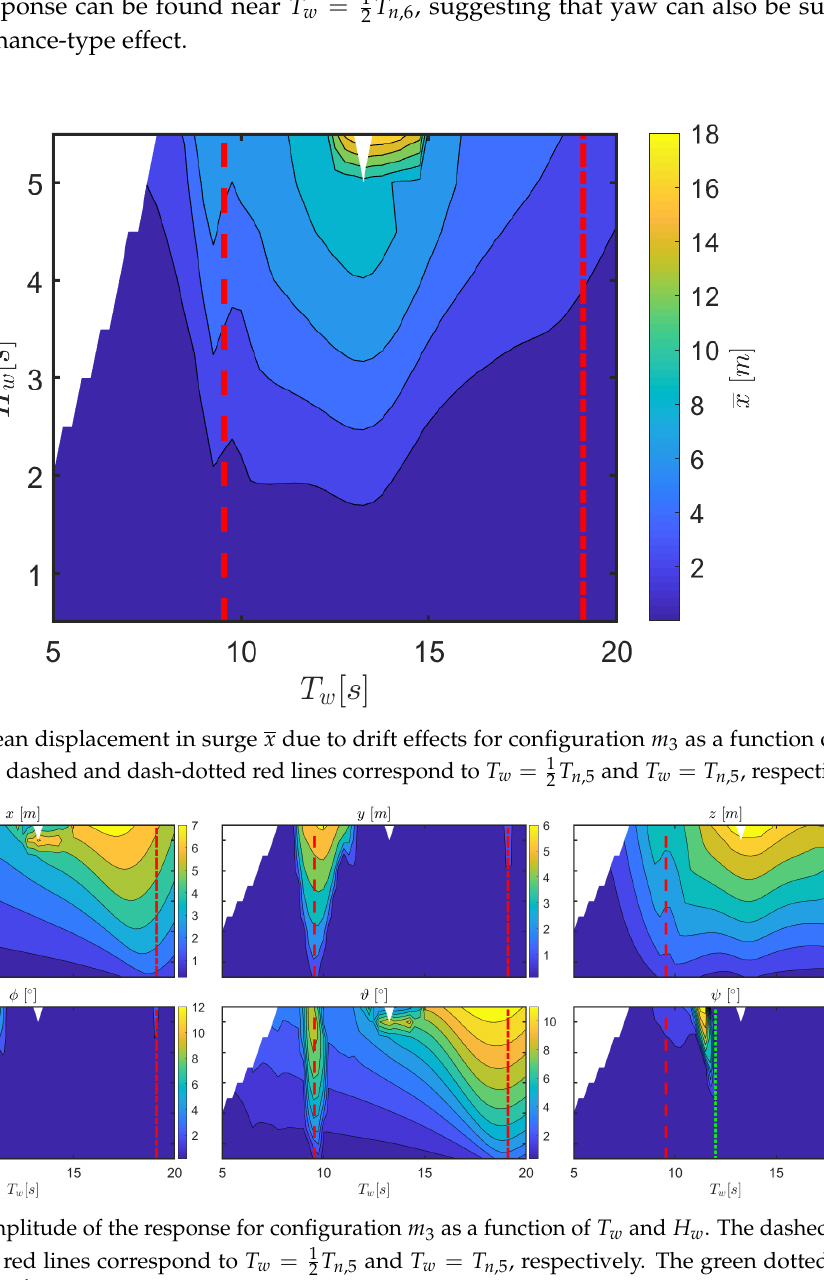
Figure 6. Amplitude of the response for configuration m 3 as a function of T w and H w . The dashed and dash-dotted red lines correspond to T w = 1 T n ,5 and T w = T n ,5 , respectively. The green dotted line 2 refers to T w = 1 T n ,6 2